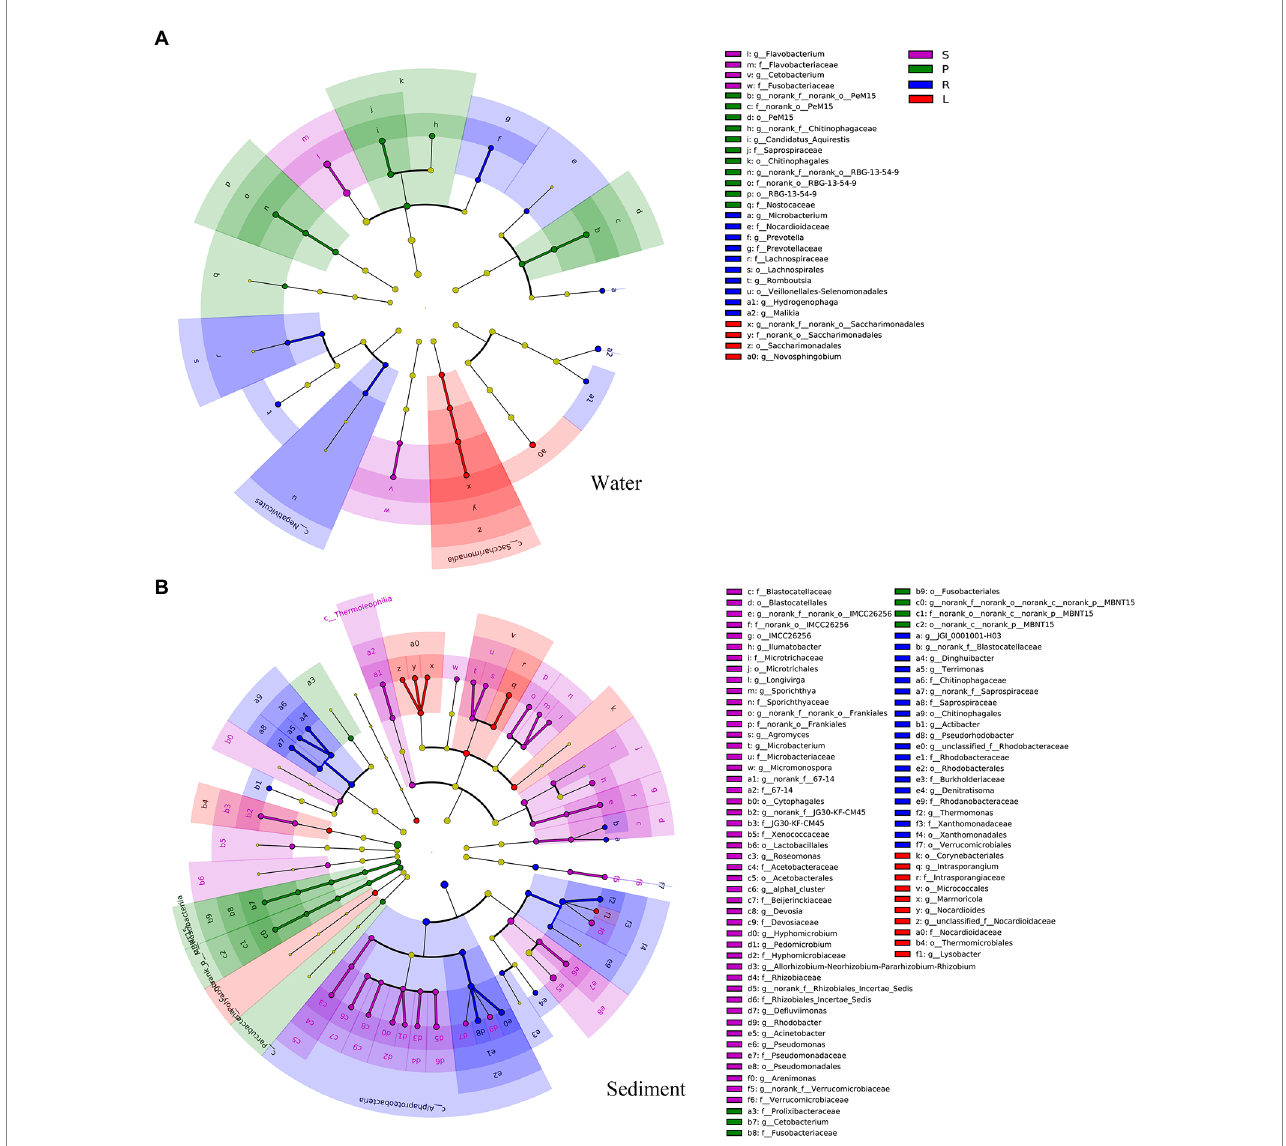
FIGURE 2 The abundant biomarkers in water (A) and sediment (B) obtained for four habitats. All detected taxa, with a relative abundance of >0.5% in at least one sample, were assigned to phyla (outermost), classes, orders, families, and genera (innermost) and were used to determine the taxa or clades most likely to explain differences between the four